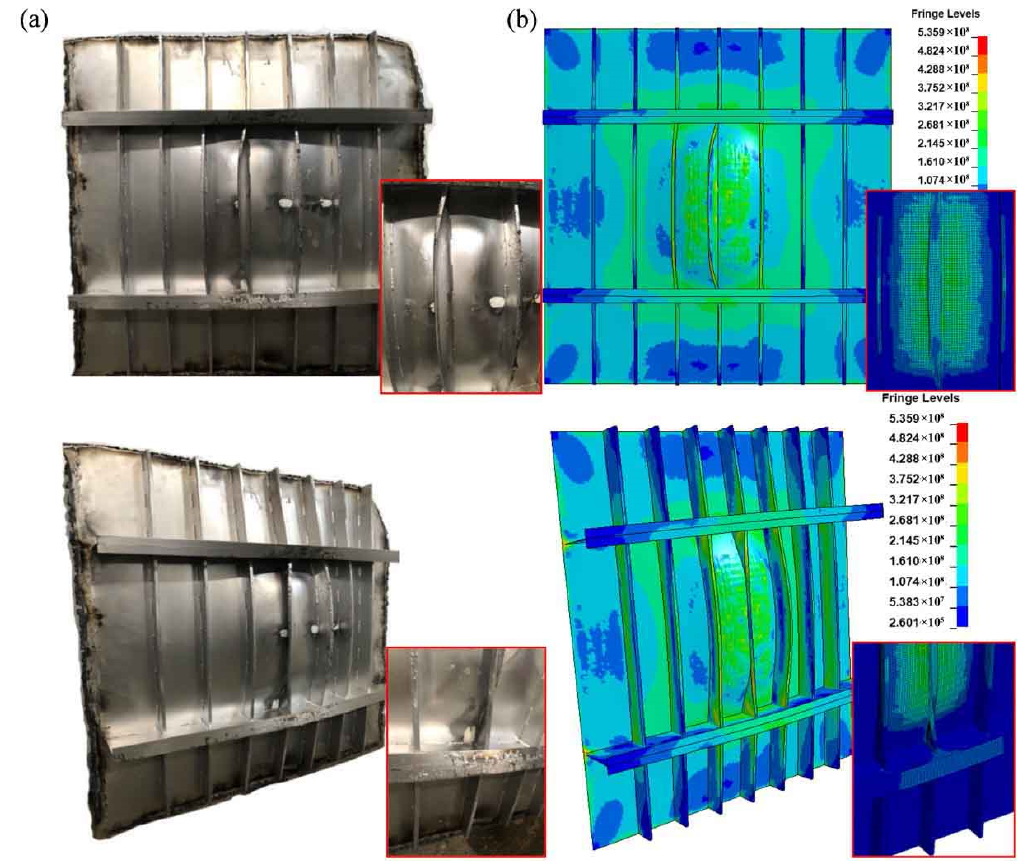
Figure 21. Comparison of the stiffened panel’s deformation between the experiment and simulations: ( a ) Impact test; ( b ) Numerical simulation.